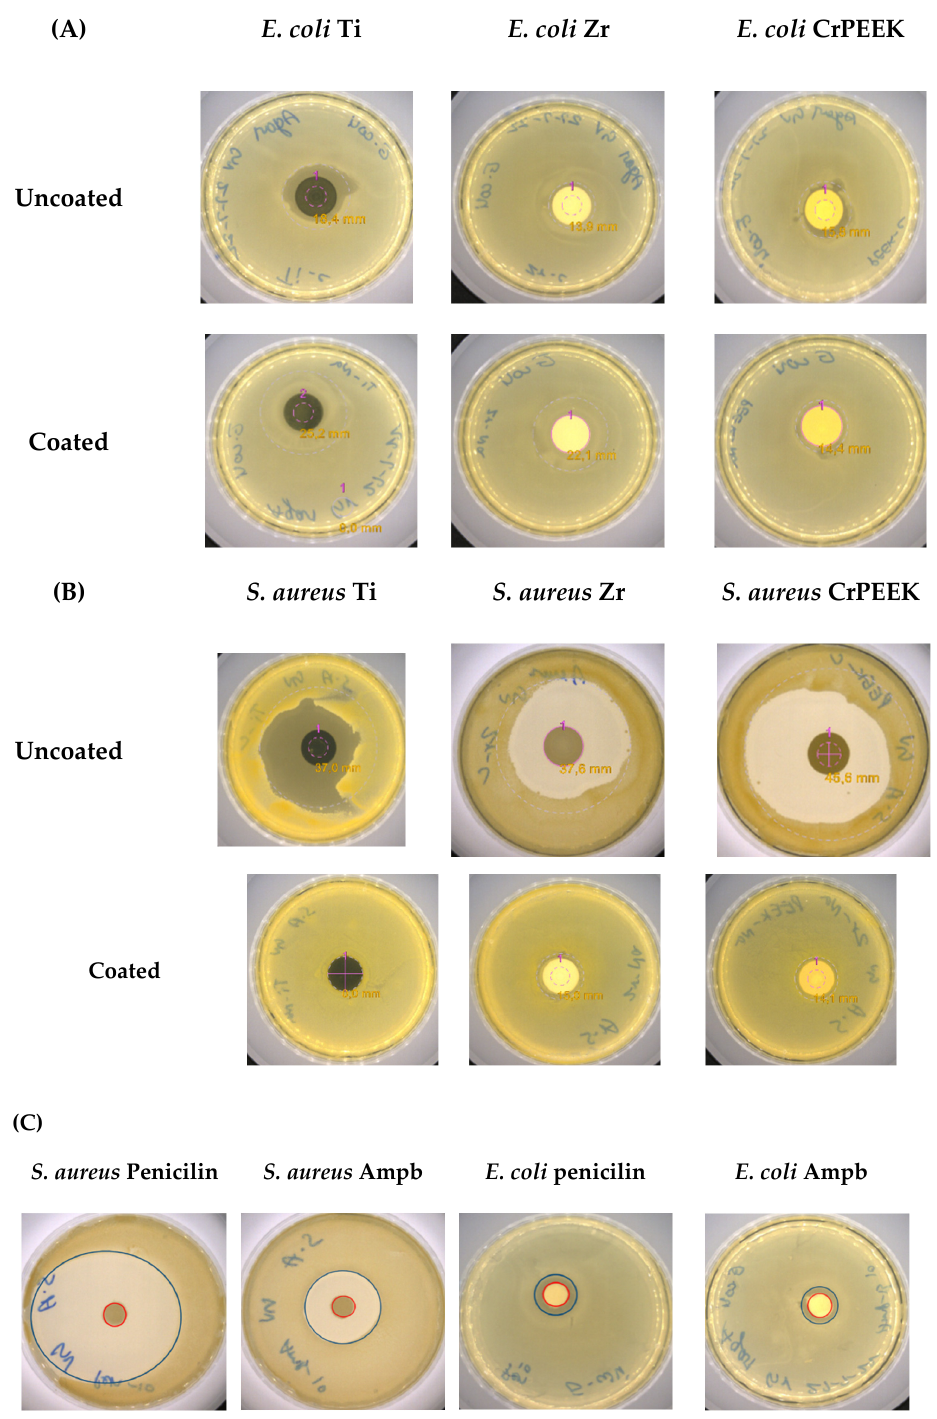
Figure 5. Macroscopic images of the antibacterial effect of the tested samples performing the disc diffusion method using E. coli and S. aureus strains. ( A ) and ( B ) Uncoated and coated samples and ( C ) positive control of S. aureus and E. coli using penicillin (10 µL) and amphotericin B (Ampb) (10 µL). Table 1. Antibacterial effect of Ti, Zr, and CrPEEK samples against E. coli (nm) and S. aureus (nm) strains .